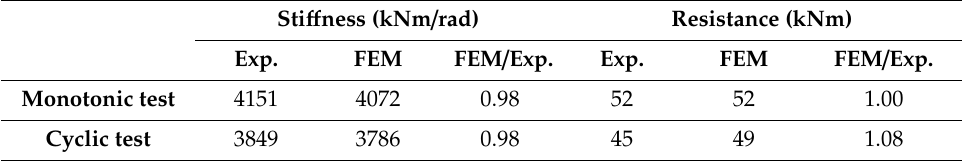
Table 1. Experimental vs. finite element (FE) results: sti ff ness and resistance